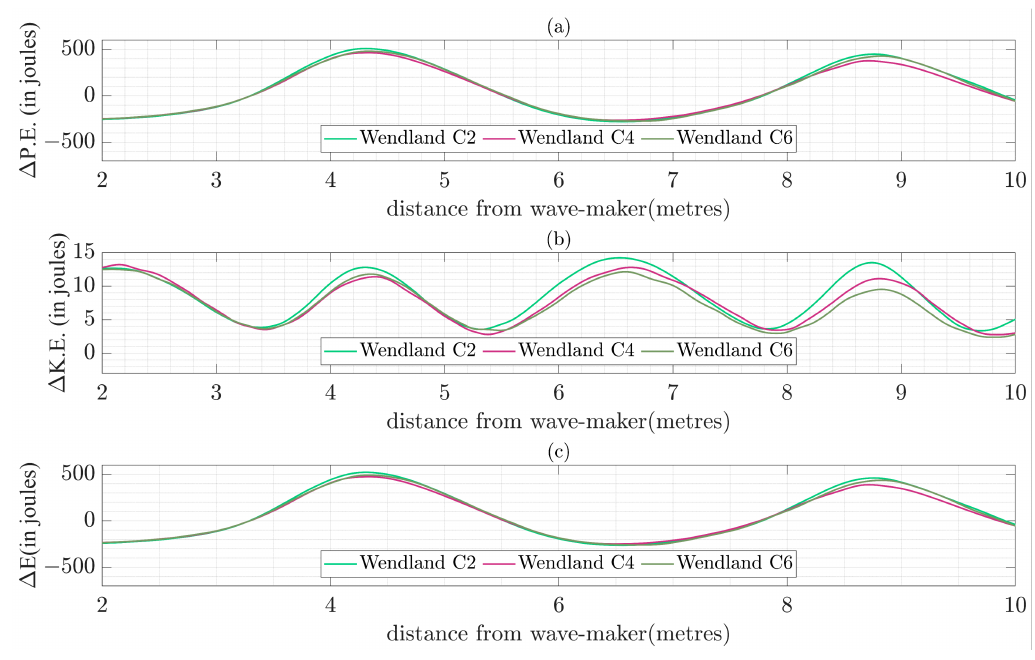
Figure 20. Comparisons over x = 2 m to x = 10 m of the wave tank with the implementations of the three Wendland kernels: ( a ) potential energy, ( b ) kinetic energy and ( c ) total energy